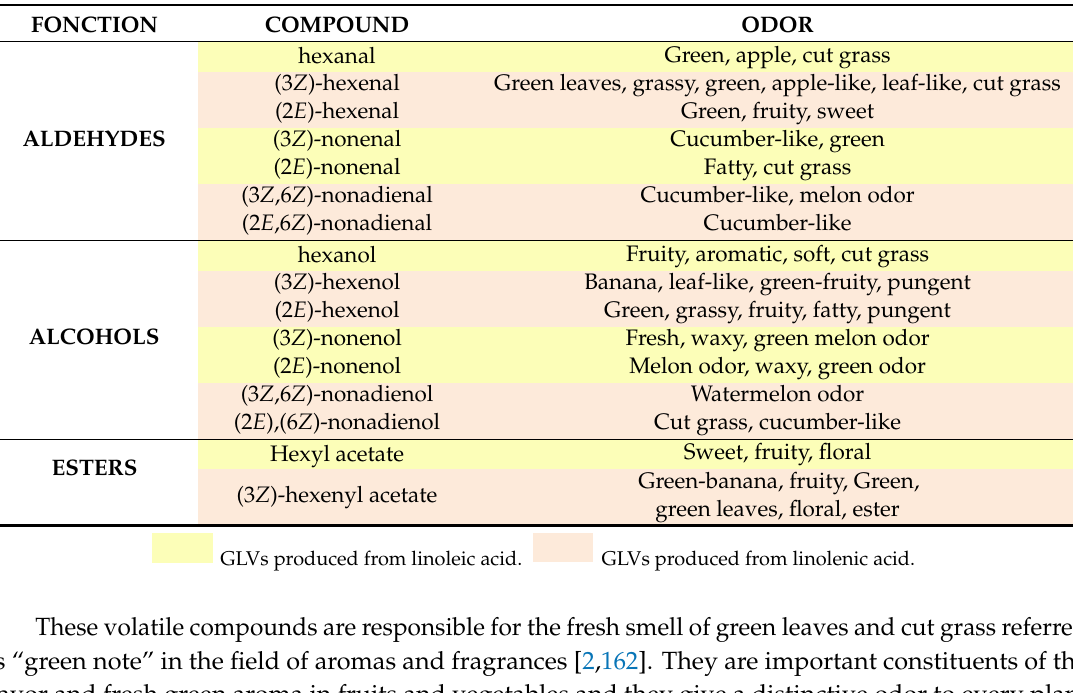
Table 1. Odor qualities attributed to green leaf volatiles (GLVs) formed by the lipoxygenase pathway.